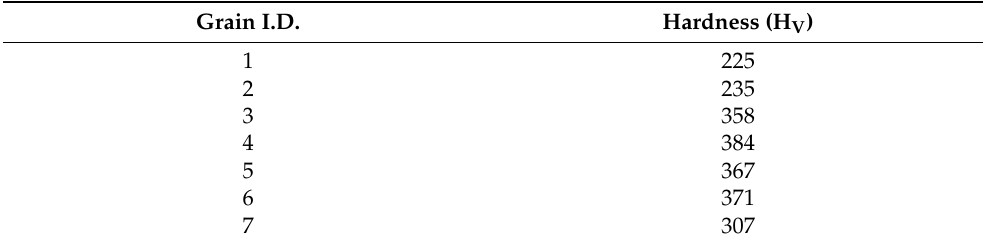
Vickers hardness measurements from the centre of seven neighbouring grains (single indentations). Grain